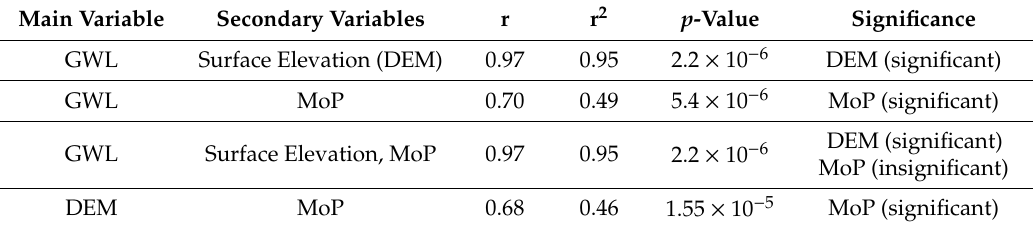
Table 1. Results of linear regression analyses among groundwater level (GWL), surface elevation (DEM), and